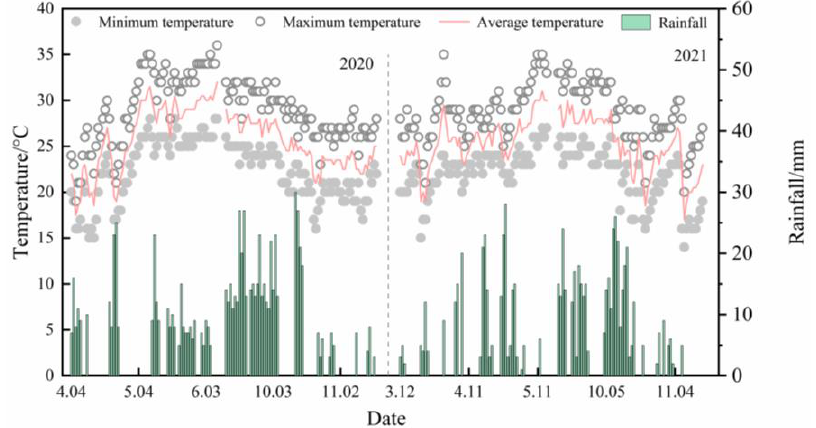
Figure 1. Average temperature ( ◦ C), maximum temperature (mm), minimum temperature (mm) and rainfall for each fertility period of maize in 2020–2021 at the National Experimental Station for Soil Quality Zhanjiang Observation.